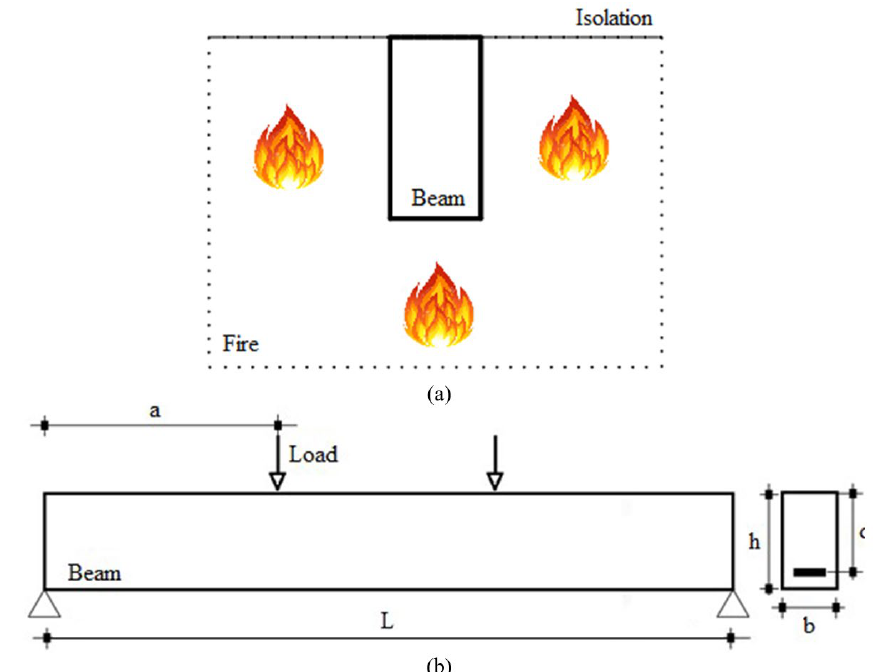
Figure 1. Tests (a) heating phase on cross section and (b) four-point bending after fire